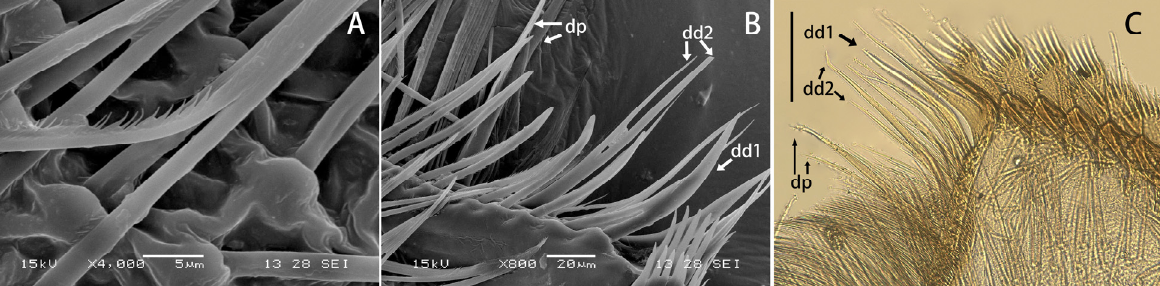
Figure 3. Maxillae of Regulaneuria cingulata ( A ) SEM view of fimbriate scattered setae on the ventral face of the galea; ( B ) SEM view of the distal dentisetae and proximal dentiseta; ( C ) Same view in optical microscope. Scale bars: ( C ) = 0.5 mm.